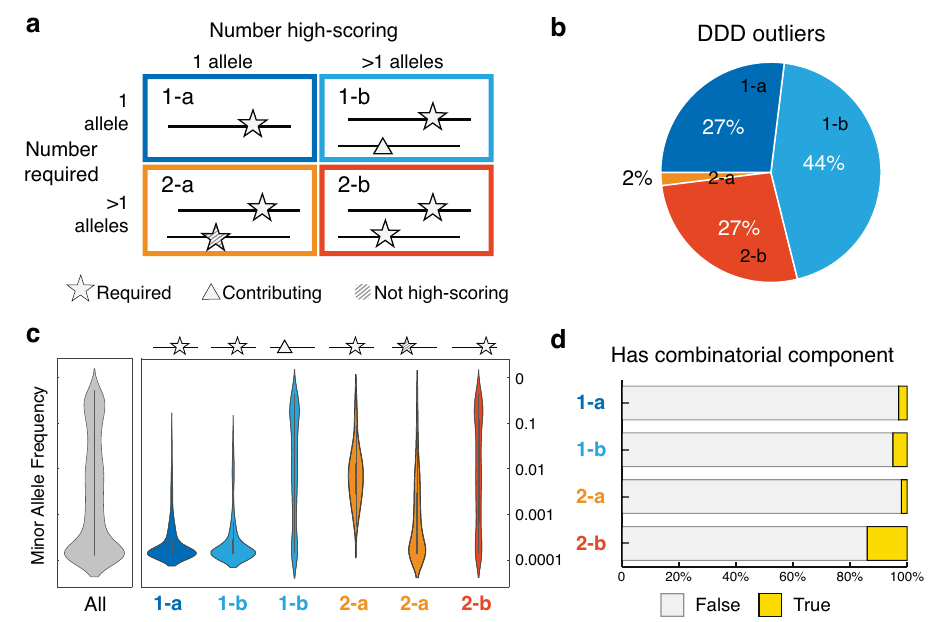
Fig.5|Typesofgeneticoutlier.a Outliersclassi fi edbyunderlyinggeneticvariants into 4 types: 1-a, single variant only required; 1-b, single variant plus contributing variant(s);2-a,multiple variants but dominated by one high-scoringvariant;or2-b, multiple variants required. b Distribution of the four types of outliers in the DDD cohort. c Violinplotstoshowthedistributionoflog-scaledminorallelefrequencies (MAF) of variants involved in all predicted outliers, and by type of outliers in the DDD cohort. Colours show different types of outliers, schemes show roles of the variants involved, similar in a . Speci fi cally, all (grey): 3682 variants involved in at